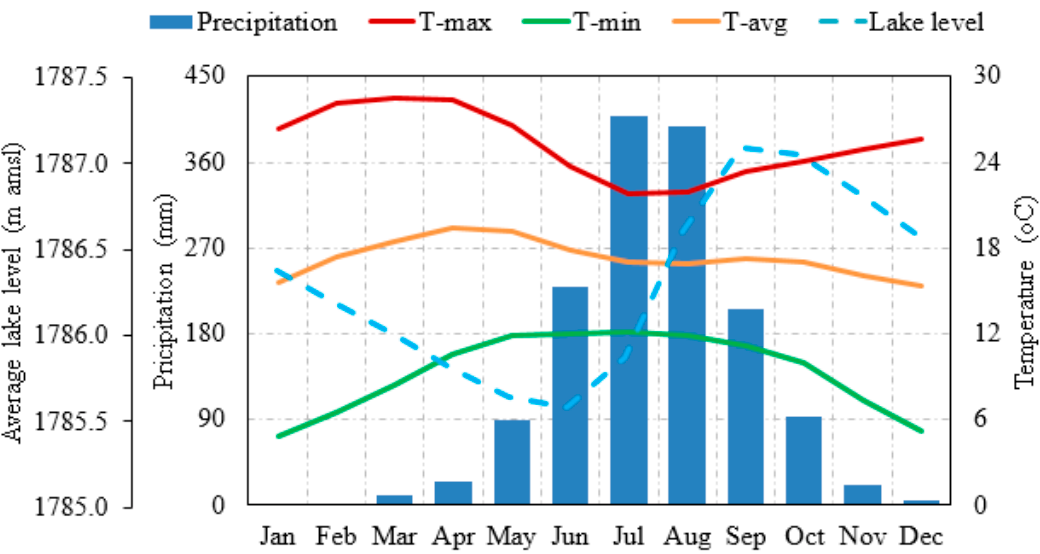
Figure 2. Average monthly rainfall (mm), minimum, and maximum temperature (°C) of Bahir Dar